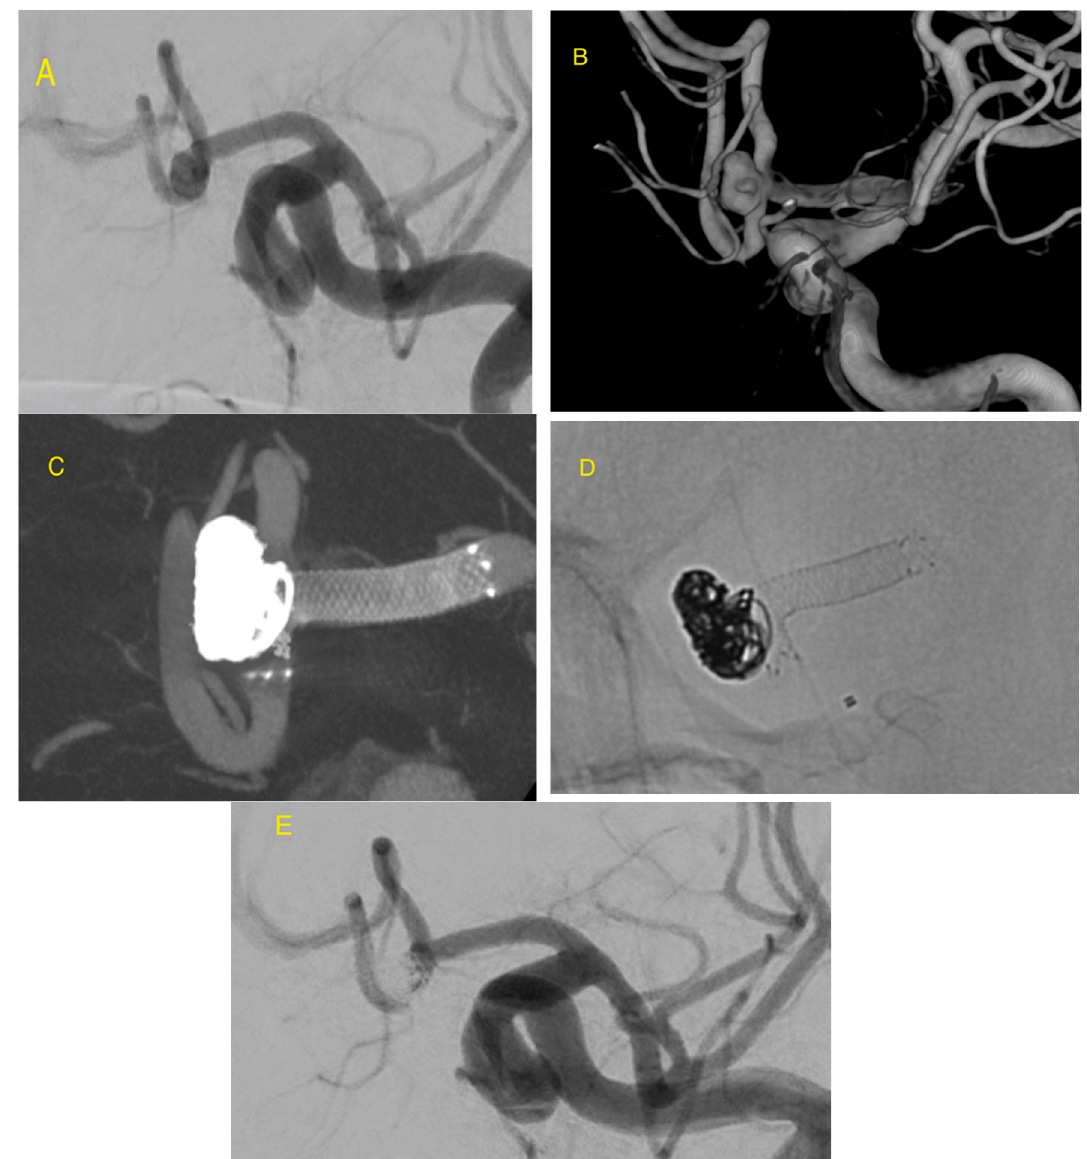
Figure 2. AComA wide-necked aneurysm is seen on DSA ( A ). Three-dimensional reconstruction of a rotational angiography ( B ) demonstrates the complex aneurysm morphology. LVIS EVO stent assisted coiling was used to treat this ruptured aneurysm. Flat panel detector computed tomography (CT) and Maximum Intensity Projection (MIP) reconstruction ( C ) and X-ray picture ( D ) showing very flexible stent arm, angled 90 degrees, protects completely the wide neck of the aneurysm from coil protrusion. DSA shows aneurysm occlusion ( E ).